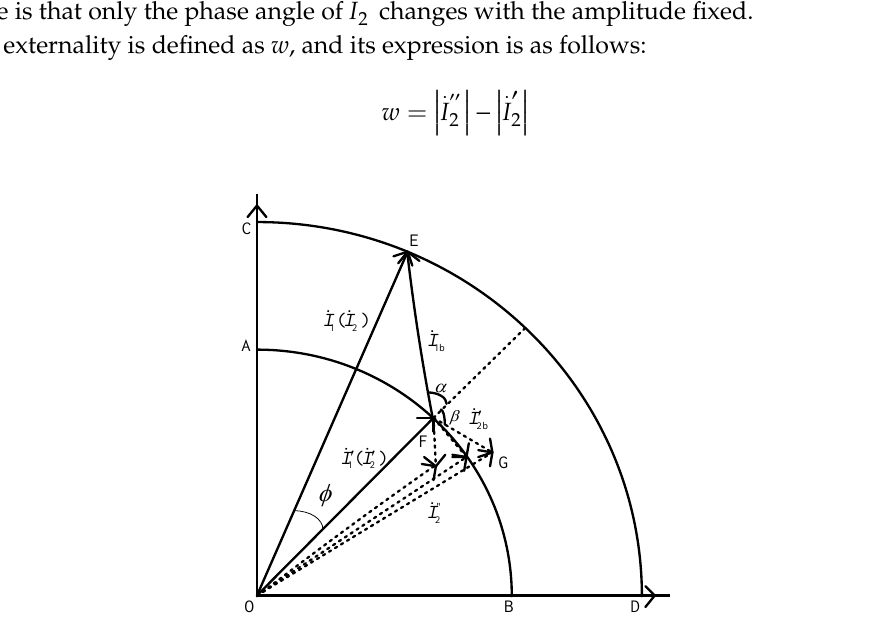
Figure 8. Phasor diagram of DVR’s externality.